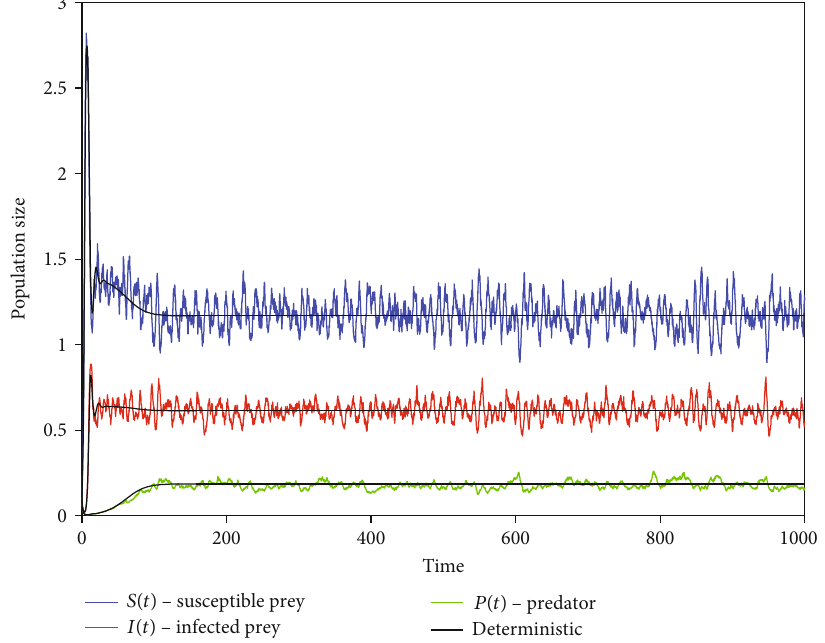
Figure 2: Simulation showing the solution curves of deterministic system (11) and corresponding stochastic system (23) with noise σ = σ = σ = 0 : 04 : 1 2 3